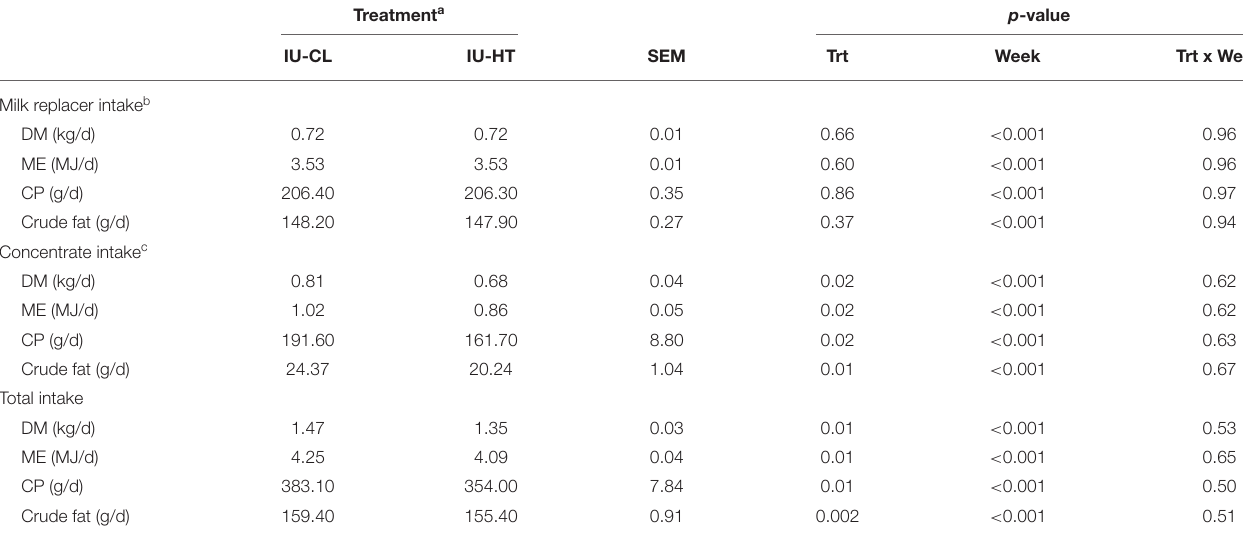
TABLE 3 | Milk replacer, concentrate, and total feed intake of dairy heifers exposed to late gestation in utero heat stress (IU-HT) or cooling (IU-CL) recorded daily and averaged at weekly. Treatment a p -value IU-CL IU-HT SEM Trt Week Milk replacer intake